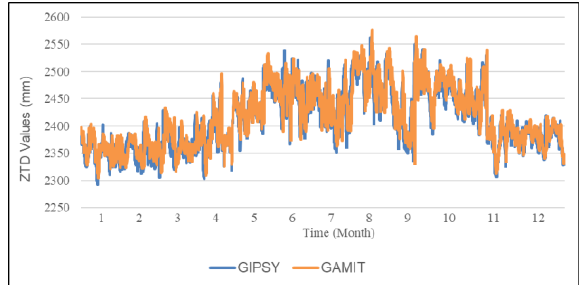
Figure 5. ZTD Estimations with GAMIT/ GlobK and GIPSY- OASIS II software.